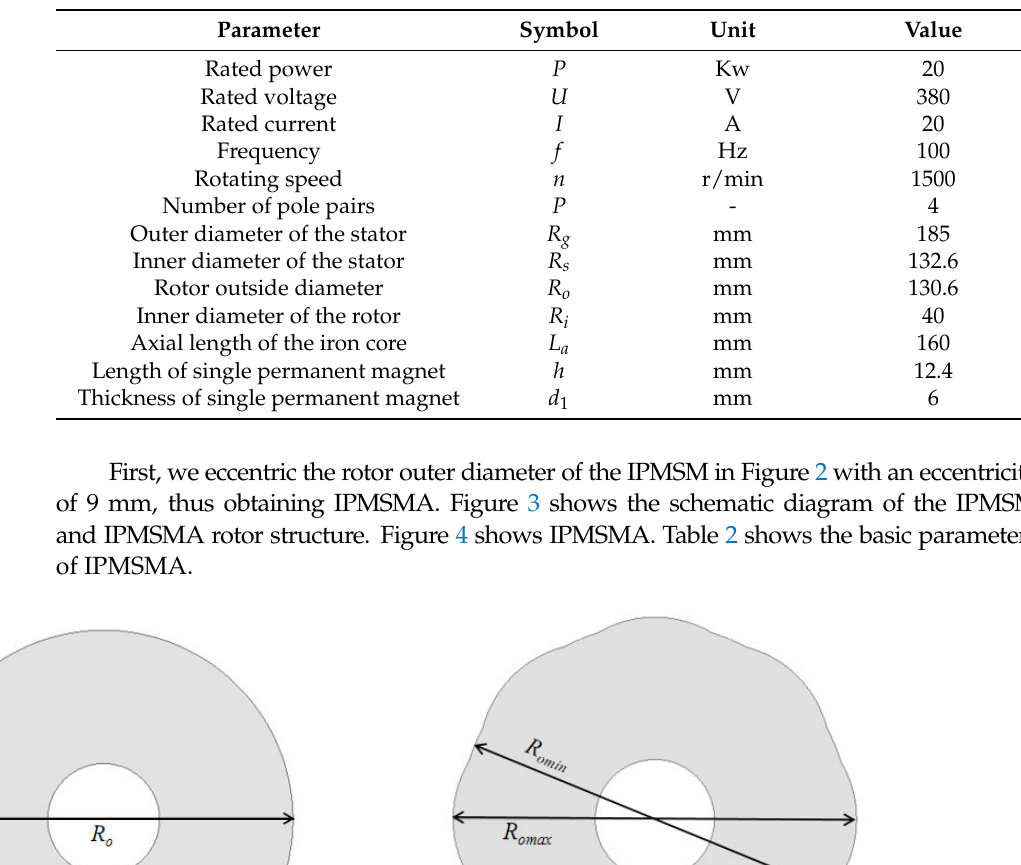
Figure 2. Schematic diagram of IPMSM. Table 1. The basic parameters of IPMSM.